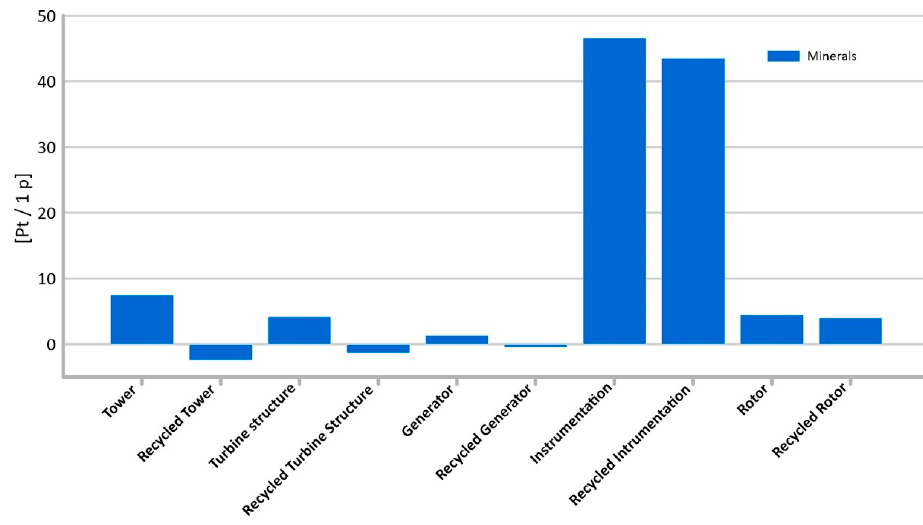
Figure 15. Results of grouping and weighting—minerals.